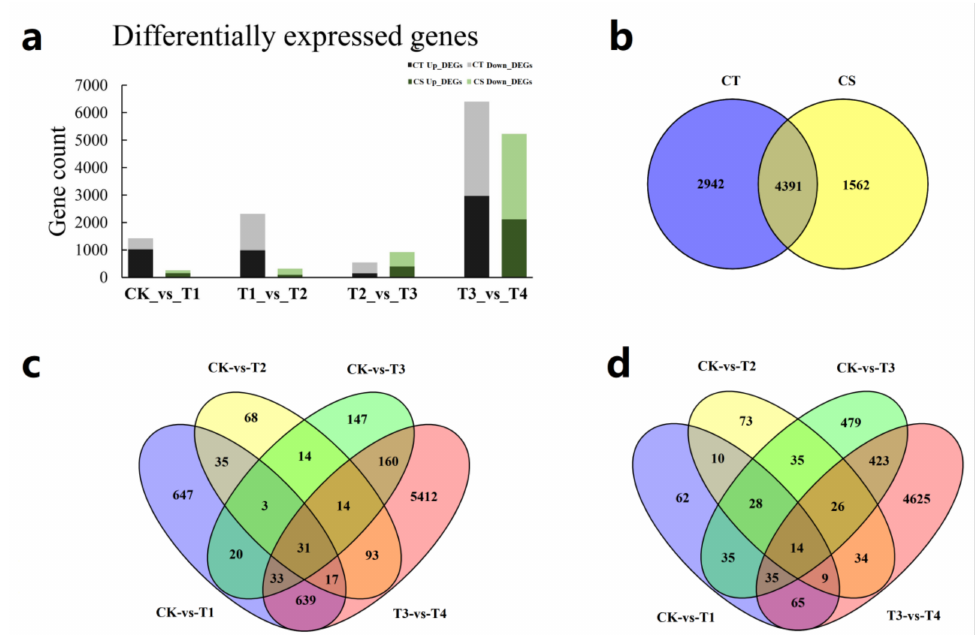
Figure 2. Differentially expressed genes (DEGs) under cold–rewarm treatments. ( a ) The DEGs specific to each cold treatment by comparing with the previous stage. ( b ) Venn diagram for total DEGs of two cultivars. ( c ) Venn diagram for DEGs in CT. ( d ) Venn diagram for DEGs in